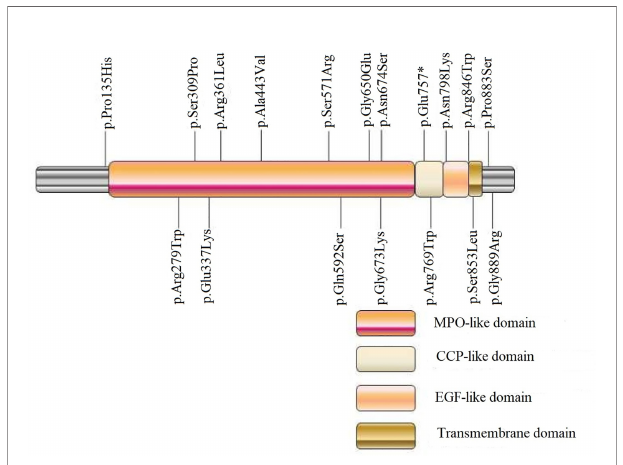
FIGURE 2 | Schematic diagram of detected exonic variants in TPO protein domains. MPO, myeloperoxidase; CCP, complement control protein; EGF, epidermal growth factor. p.Glu757*, * was used to describe a stop